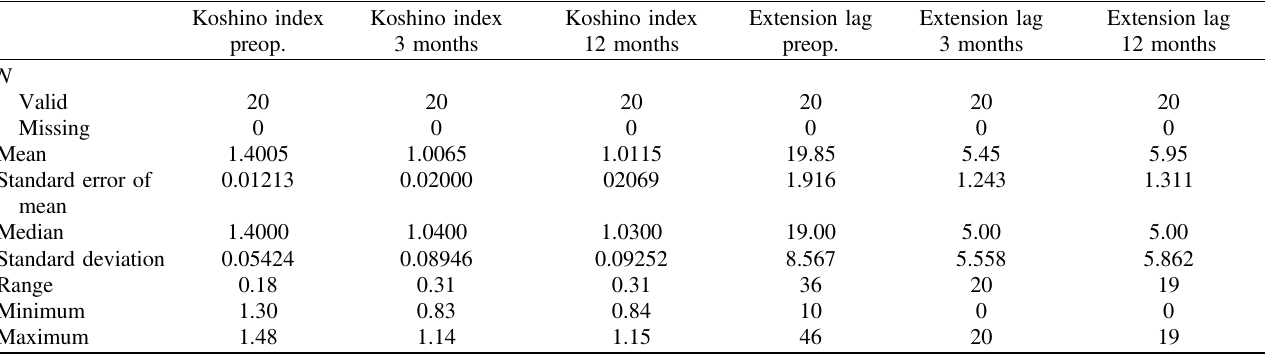
Table 2. Koshino index and extensor lag.